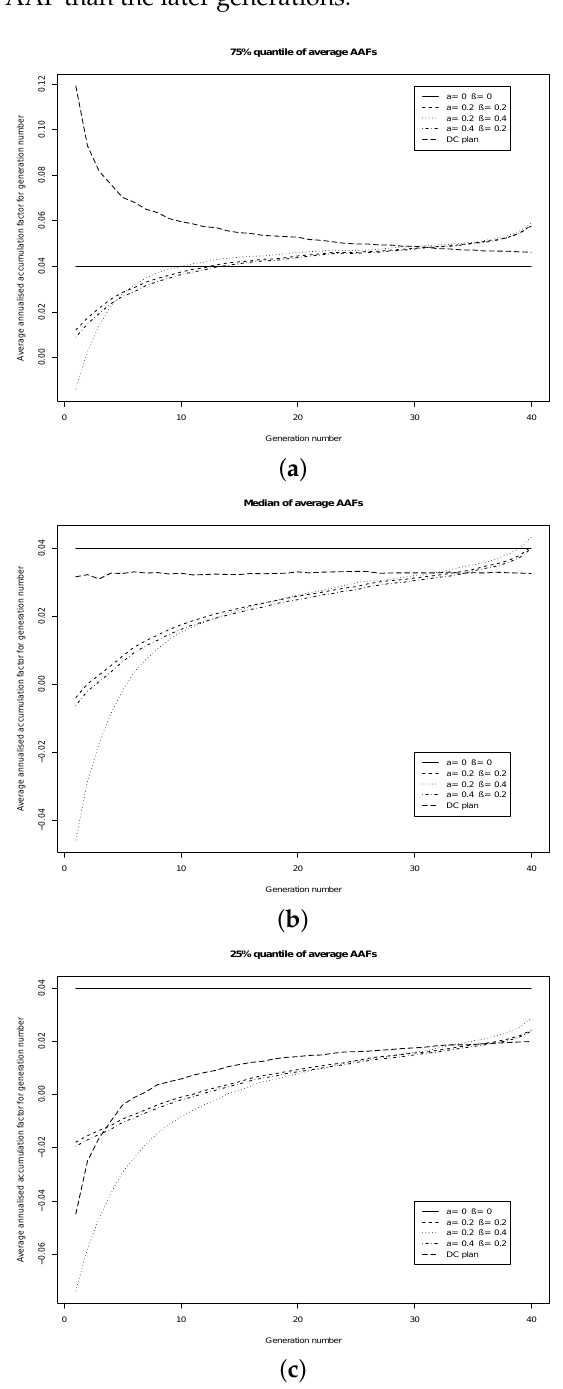
Figure 6. The annualized average accumulation factor for each generation in the model, for the more realistic membership, as both the investment risk adjustment ( a ) and the AAF adjustment ( b ) are varied. The target funding level is ¯ F = 120%. In this membership profile, the k th generation contributes $ ( 40 (cid:0) k + 1 ) at time 0, and contributes a further $1 per annum at the end of each year that they are not retired. ( a ) 75% quantile, ¯ F = 120%; ( b ) Median, ¯ F = 120%; ( c ) 25% quantile, ¯ F =